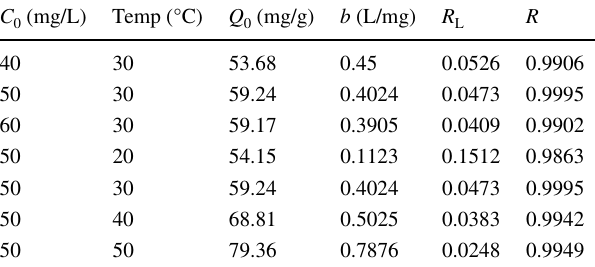
Table 2 Langmuir isotherm constants at different concentrations and